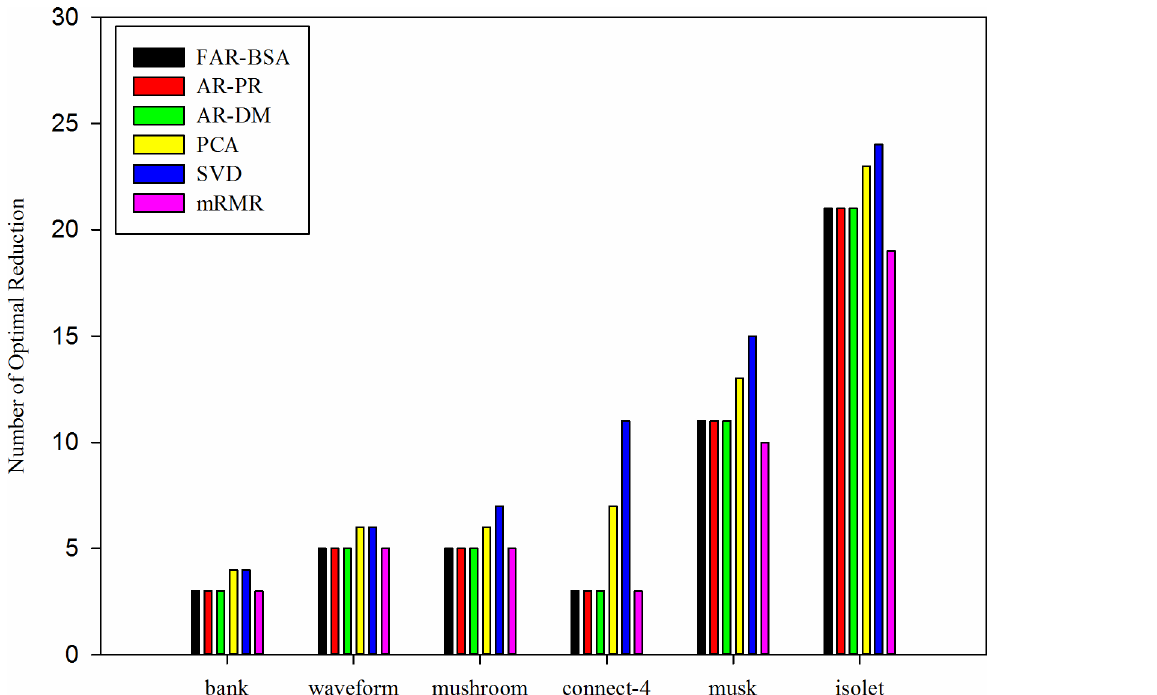
Fig 2. Comparison of the number of optimal reductions under different attribution reduction algorithms.